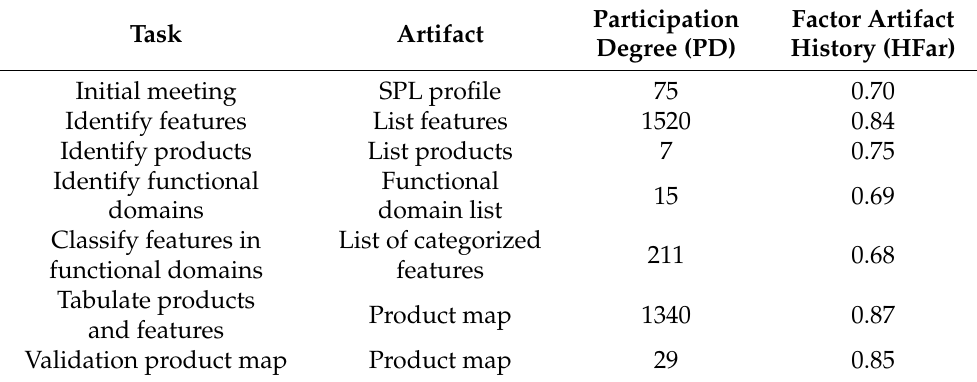
Table 8. Results of quantitative indicators of the